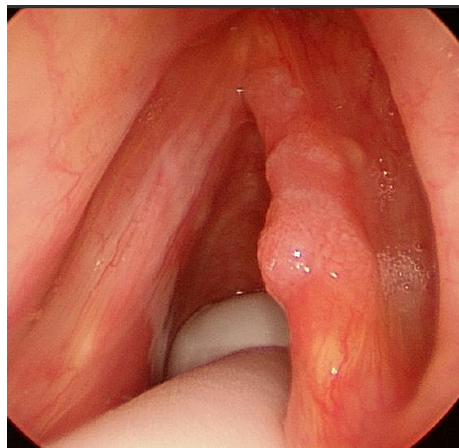
Figure 1. T1a cancer of the right vocal cord without anterior commissure (AC) involvement.